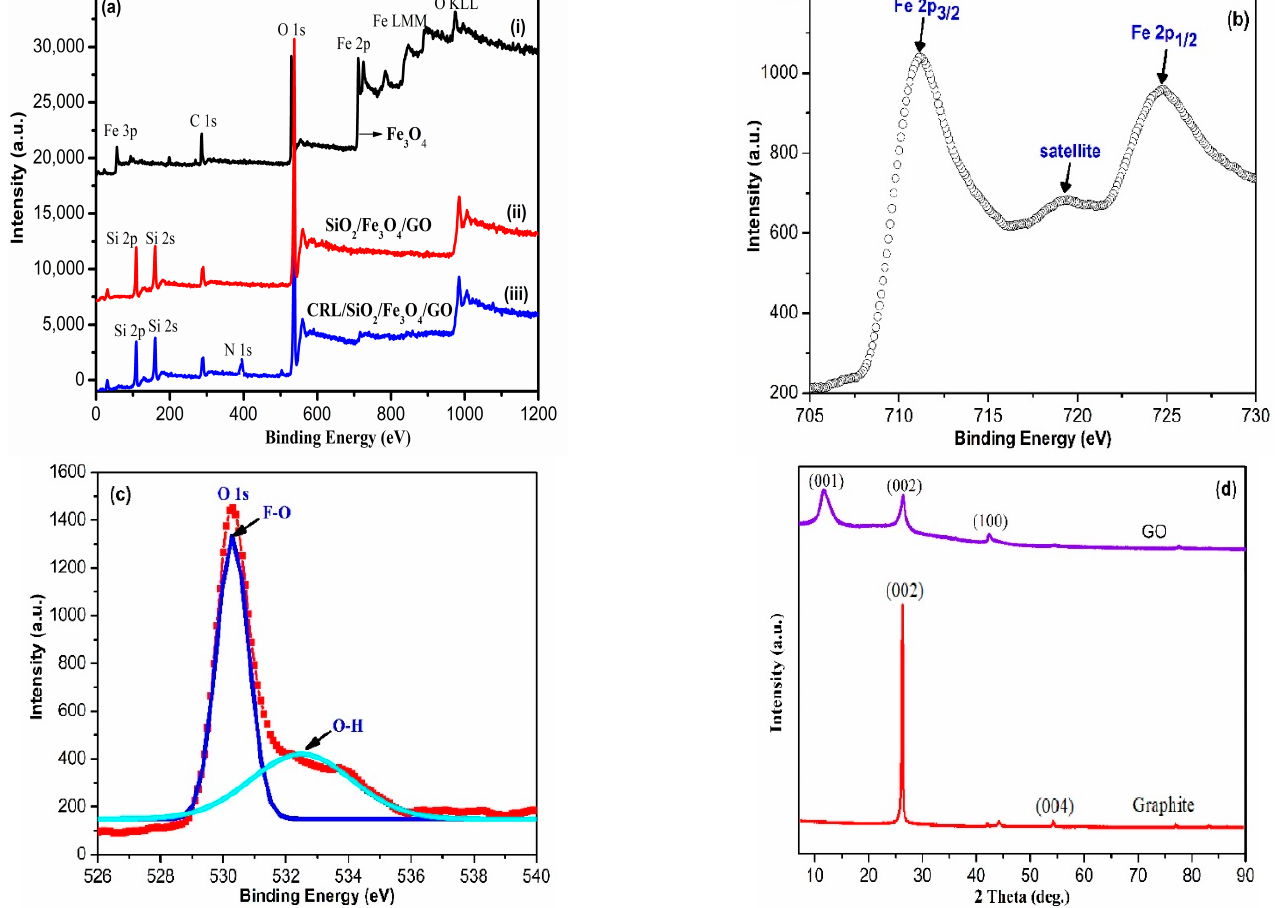
Figure 1. ( a ) XPS broad scan spectra of Fe 3 O 4 , SiO 2 /Fe 3 O 4 /GO, and CRL/SiO 2 /Fe 3 O 4 /GO, ( b , c ) the high-resolution spectrum of Fe 2p and O 1s regions of Fe 3 O 4 , respectively, and ( d ) XRD patterns of GO and pristine graphite.